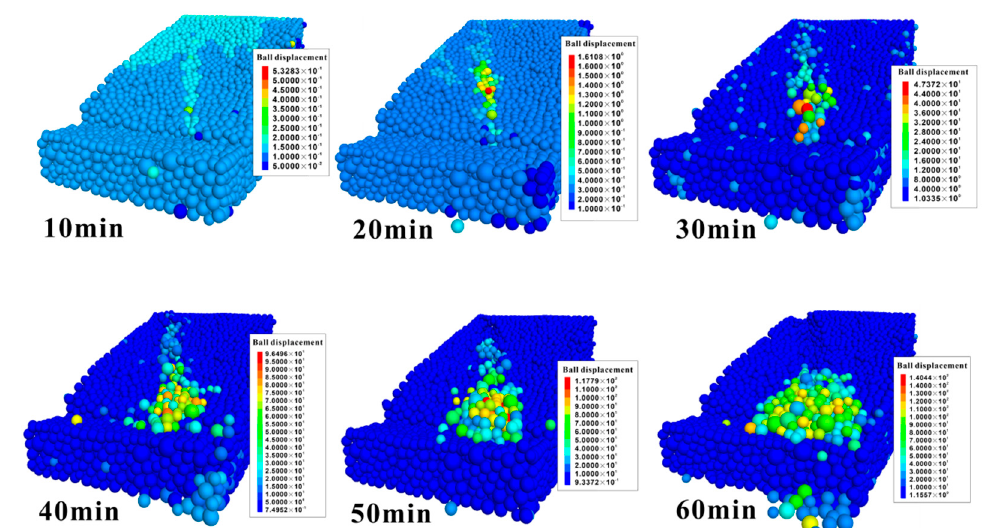
Figure 8. PFC3D model destruction process.